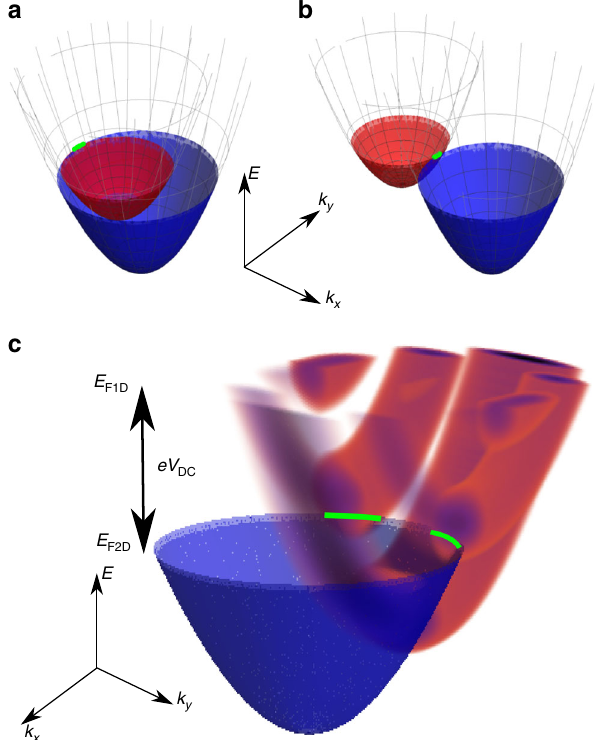
Fig. 1 Spectral functions. a , b Overlap of the spectral functions of two 2D layers as a function of momentum ð k x ; k y Þ and energy E — current only fl ows from occupied states to empty states where the spectral function is not negligible. Magnetic fi eld B displaces one paraboloid to the right. Fermi circles touch on the inside/outside, probing states of the red paraboloid = k near (cid:2) k at the Fermi energy E F . c A 2D system (blue) probing multiple F F subbands of a 1D system (red), for fi nite V